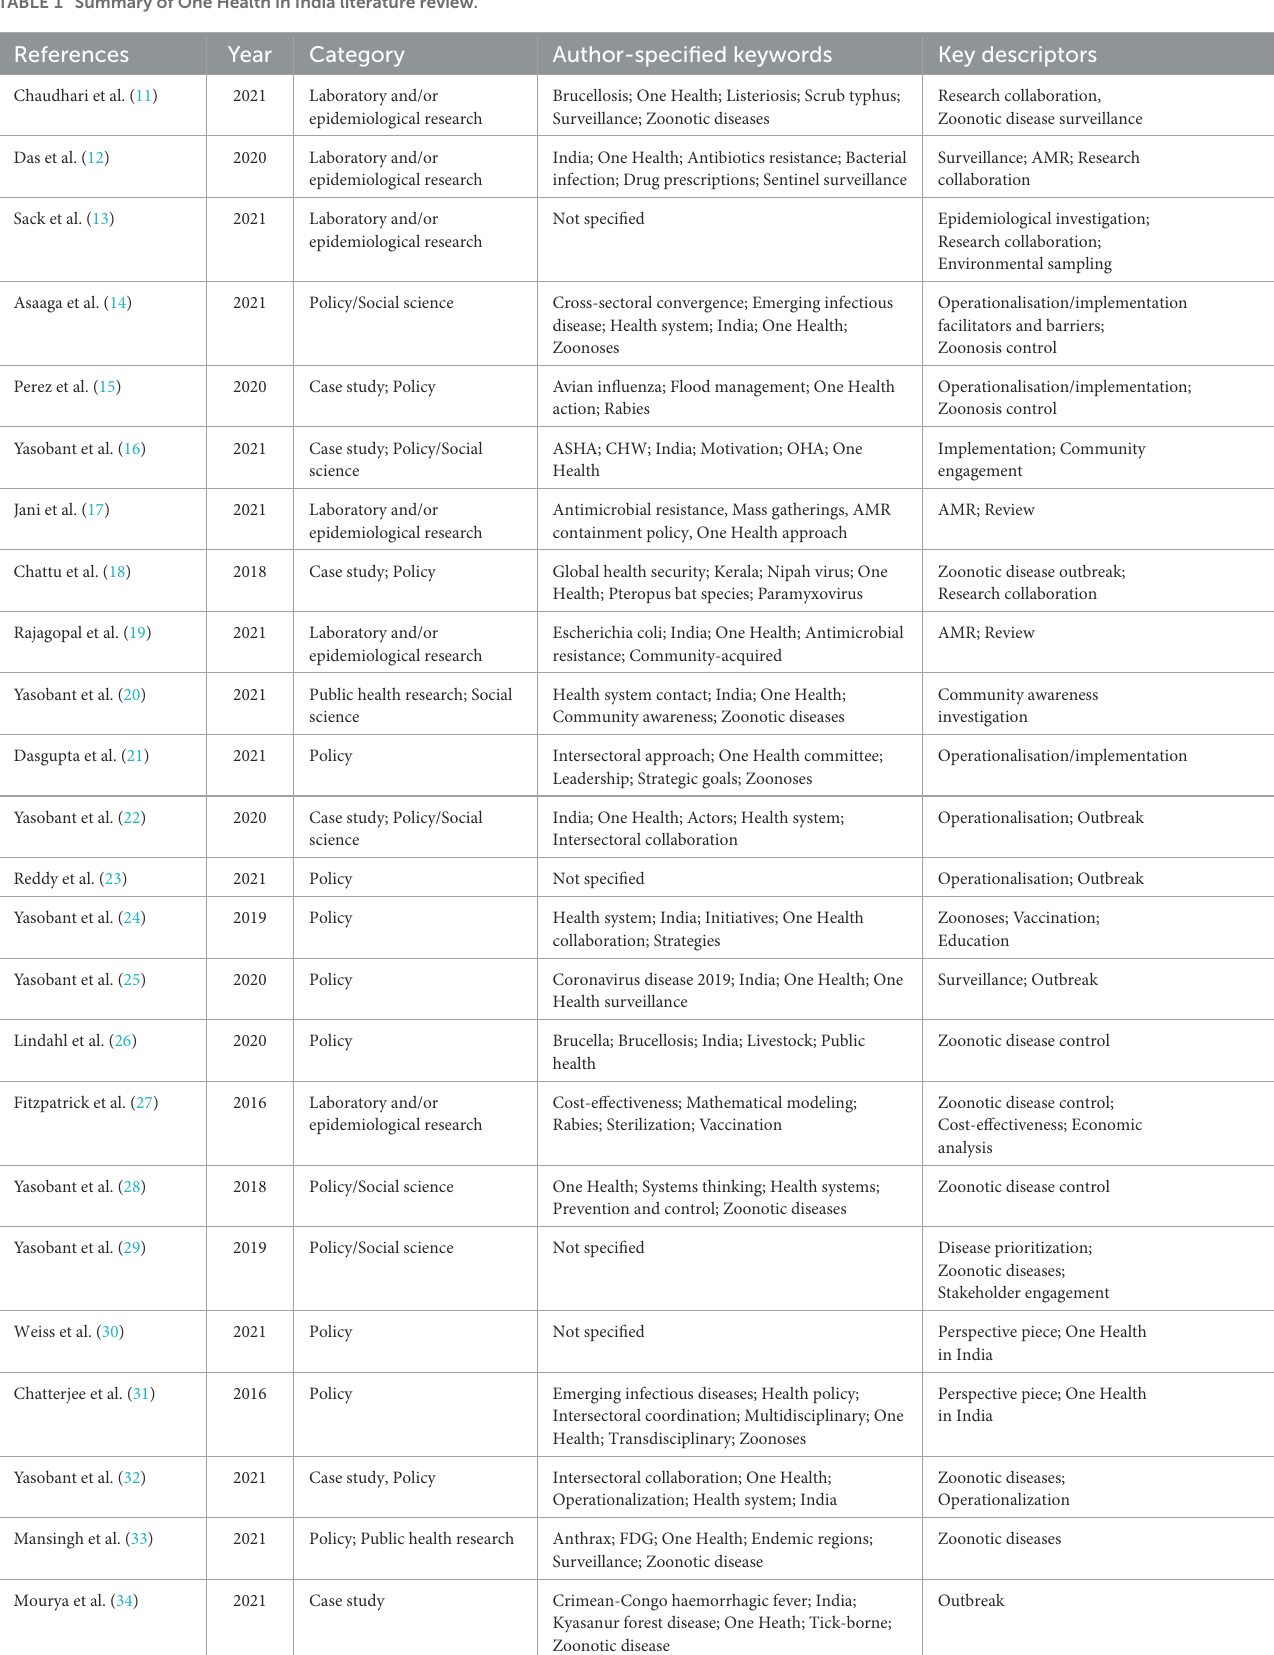
TABLE 1 Summary of One Health in India literature